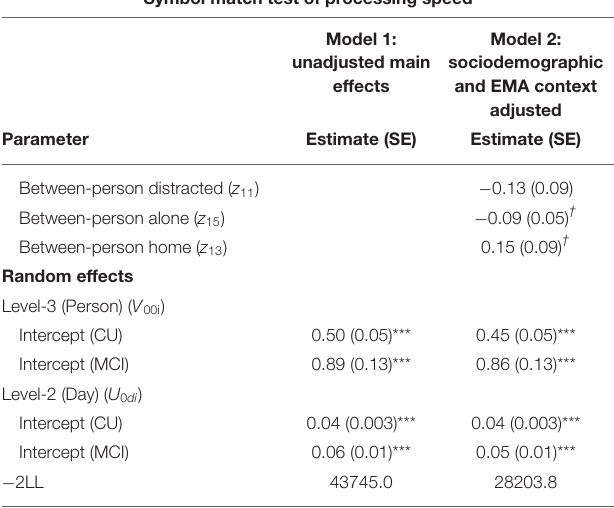
TABLE 2 | Heterogeneous variance models examining cognitive status differences in mean and variability in symbol match